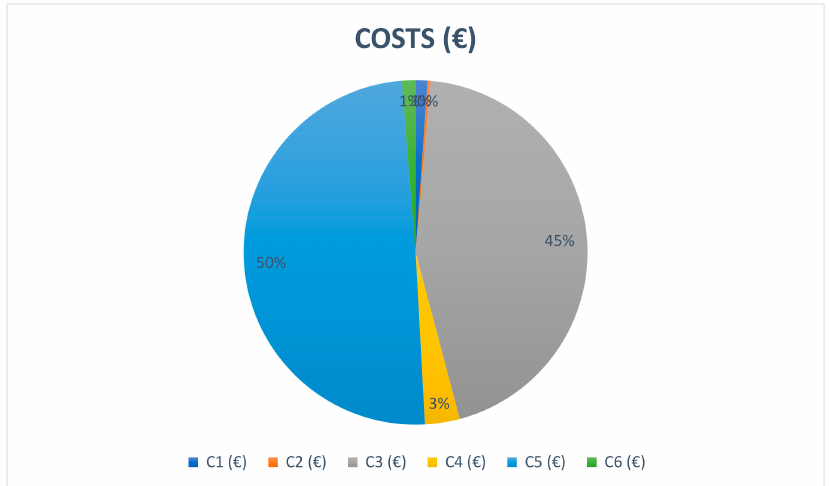
Figure 9. Life-cycle cost of S ã o Jorge.